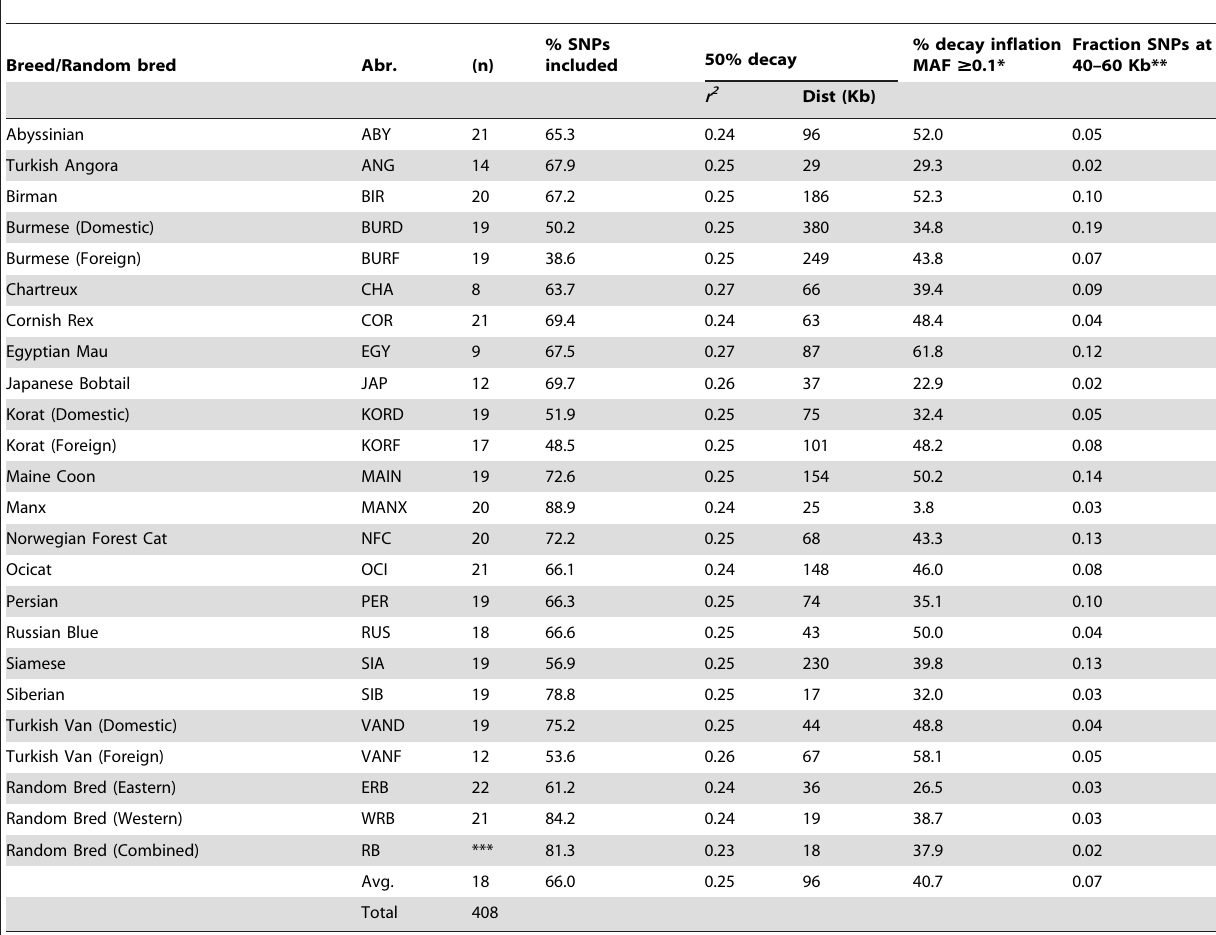
Table 1. Population and statistic summary of cat breeds for LD study.